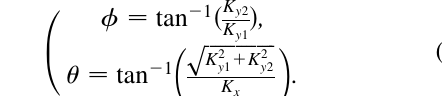
=K FIG. 2. K dependence of P . Each line shows the y 2 y 1 C different harmonics from the 0.5th to the 2nd. The K and K (cid:1) 3 : 4 . The fundamental photon are fixed at K (cid:1) 5 : 4 and K x energy is 300